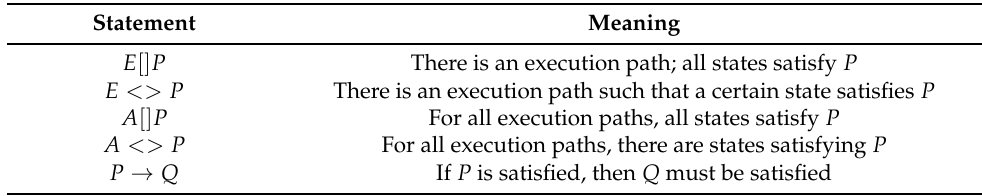
Table 1. The grammatical meaning of BNF.